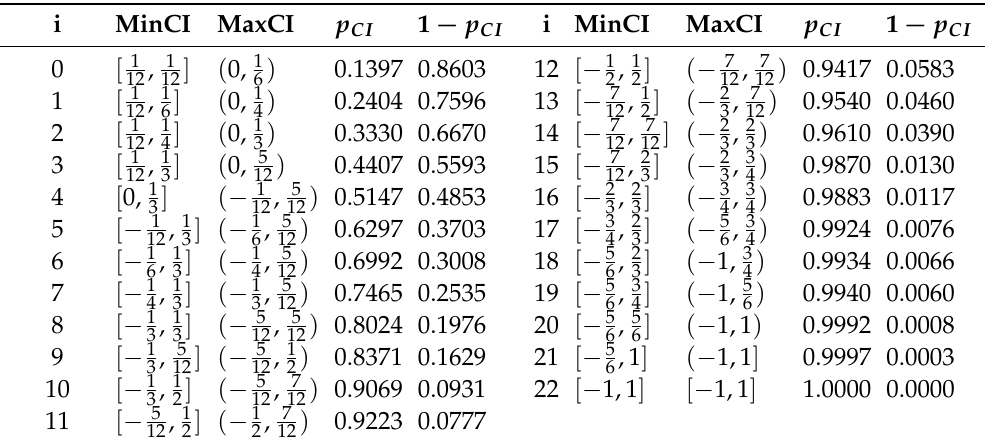
Table 3. CIs in increasing coverage for ER (data from Table